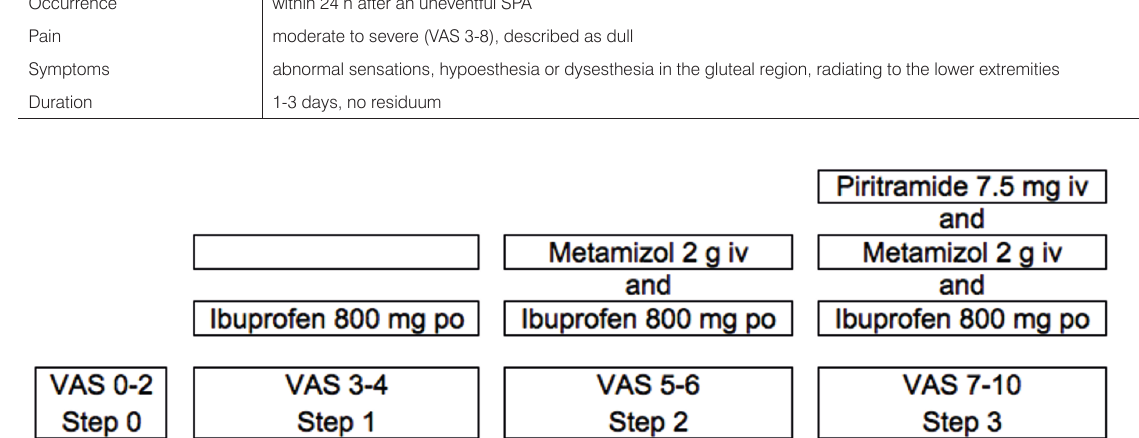
Figure 1. Step diagram for the administration of analgesics. Diclofenac was the only drug given routinely (100 mg in form of a suppository at the end of surgery). All other analgesics were given on demand only. When the pain was persistent in patients with a visual analogue scale (VAS) score of 7-10, the dosage of piritramide could be increased.